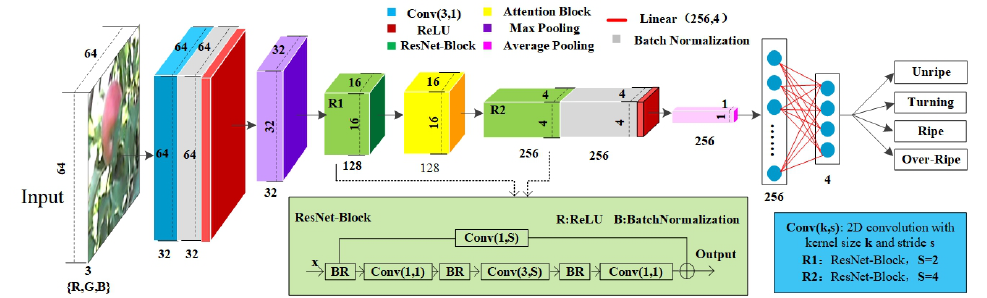
Figure 4. The architecture of our proposed